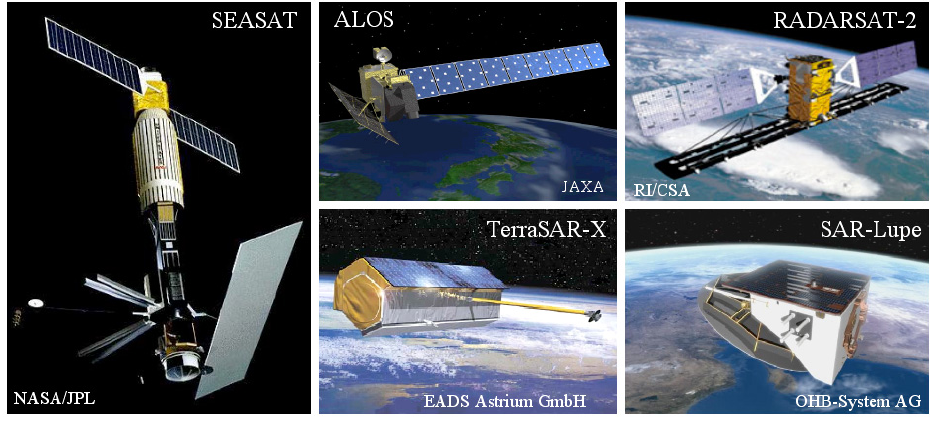
Figure 3. Illustration of SEASAT, ALOS, RADARSAT-2, SAR-Lupe, and TerraSAR-X satellites.